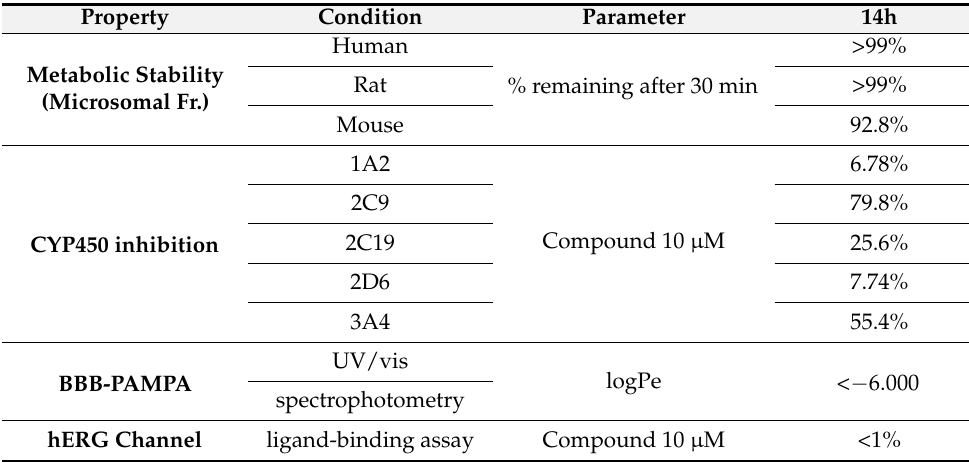
Figure 3. The in vitro antagonistic activity of compound 14h . Table 4. In vitro pharmacokinetic and hERG channel studies of compound 14h